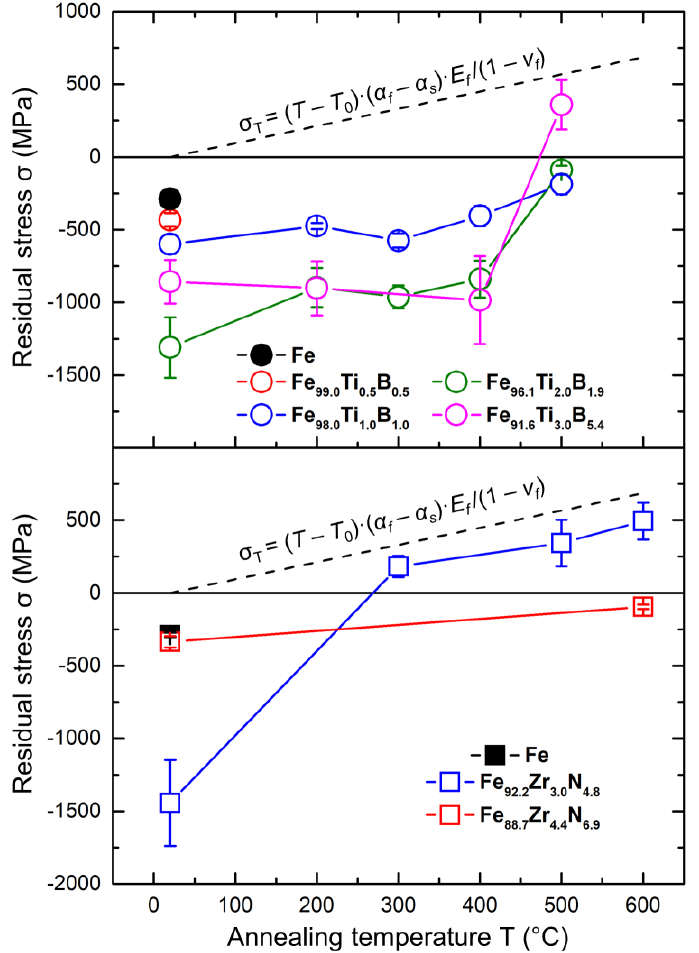
Figure 4. Dependences of the residual stresses in the studied films on the annealing temperature. The dashed lines show dependence (3).